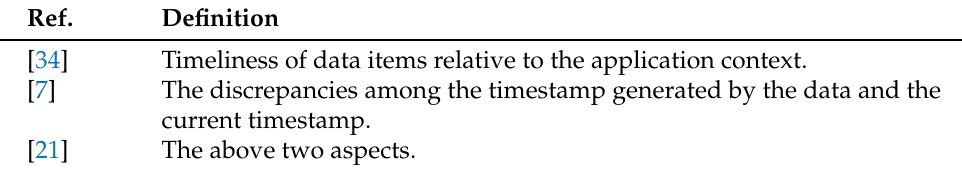
Table 5. Definition of